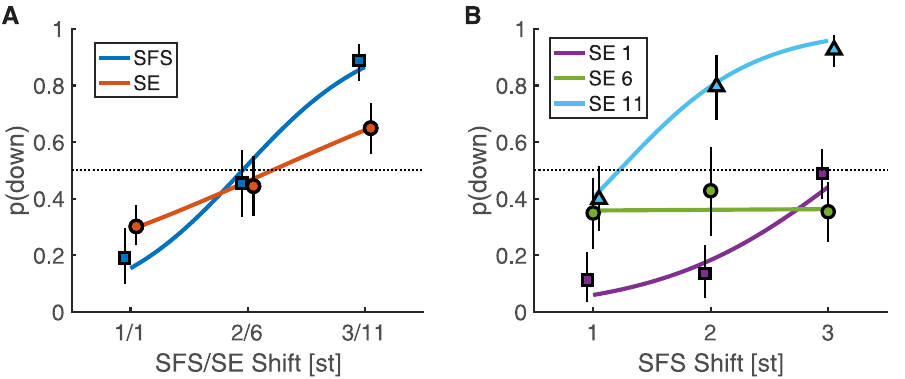
Fig 4. Proportion “down” responses in Exp. 3 with log-equidistant partials for one-dimensional shifts (A) and two-dimensional shifts (B). Colored lines indicate the fixed effects of the GLME model. Black vertical lines indicate 95% confidence intervals obtained by